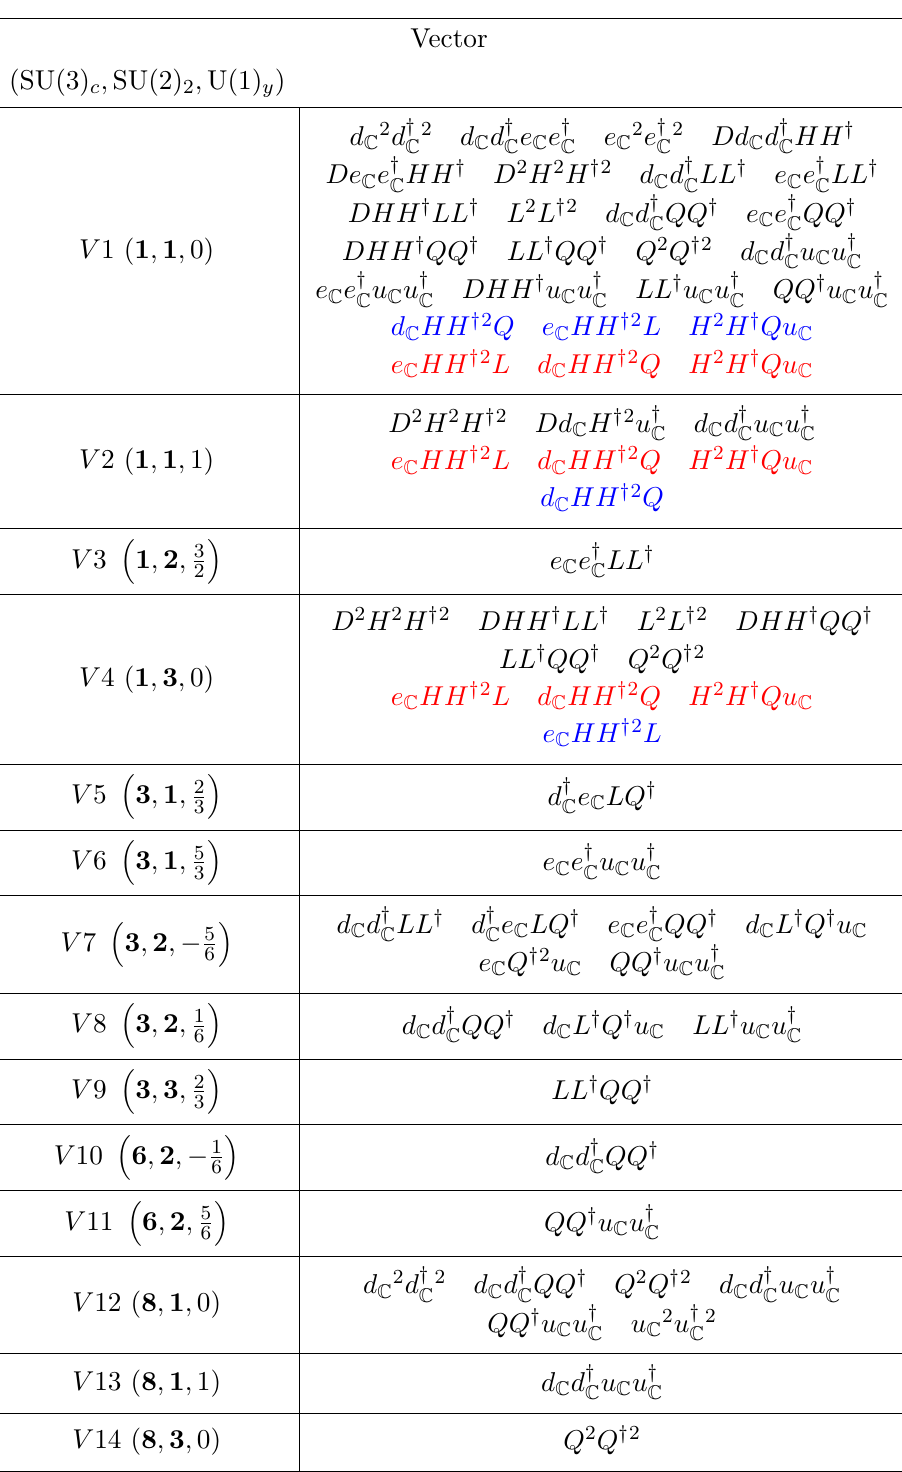
Table 17 . Vector resonances which could generate the dim-6 operators. The name of the resonances is organized by the gauge quantum number. The resonance appeared in the squared bracket of the operator indicate that both resonances are needed to generate such